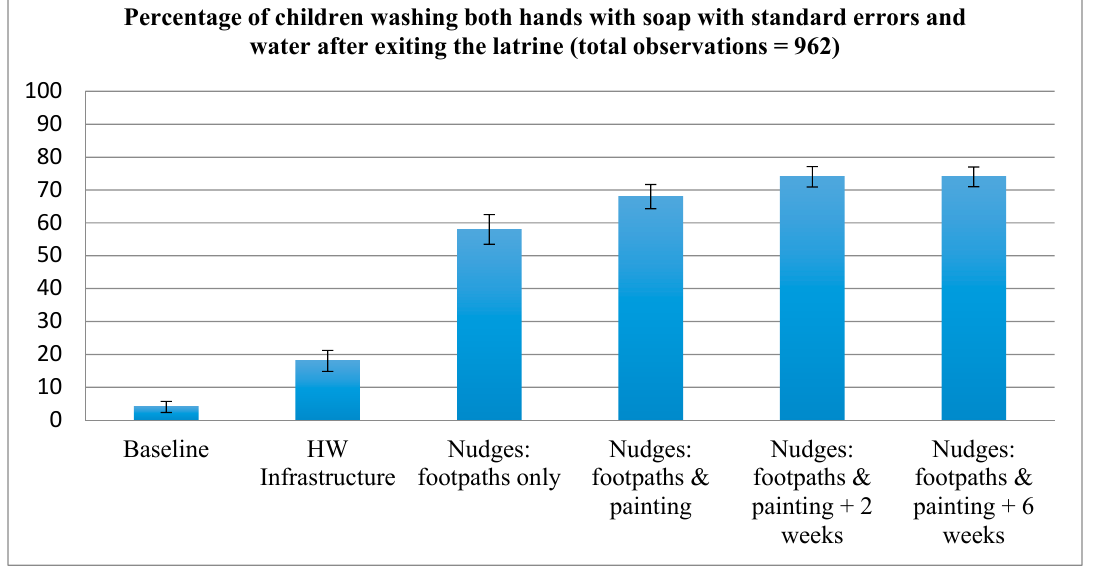
Figure 3. Percentage of children washing both hands with soap following latrine use in two primary schools in rural Bangladesh. HW infrastructure (water tank and raised platform), Nudges: footpath only, and Nudges: footpaths & painting were completed the school day immediately following construction.